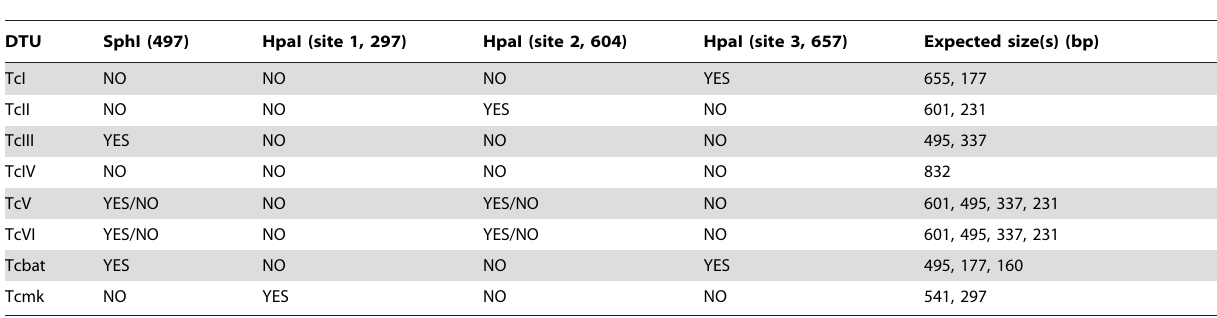
The location where the enzyme cuts the DNA is shown in parentheses. Coordinates are given with respect to the translational start codon ( + 1). The presence/absence of these sites in each DTU is noted in the table, as well as the expected number and sizes of fragments produced in a double digestion with these enzymes. All sites for lineages TcI-IV and Tcbat are present or absent in homozygosity. Some sites for lineages TcV and TcVI are present in heterozygosity, and are annotated as YES/NO, indicating both presence and absence of the site. Tcmk= T. cruzi marinkellei